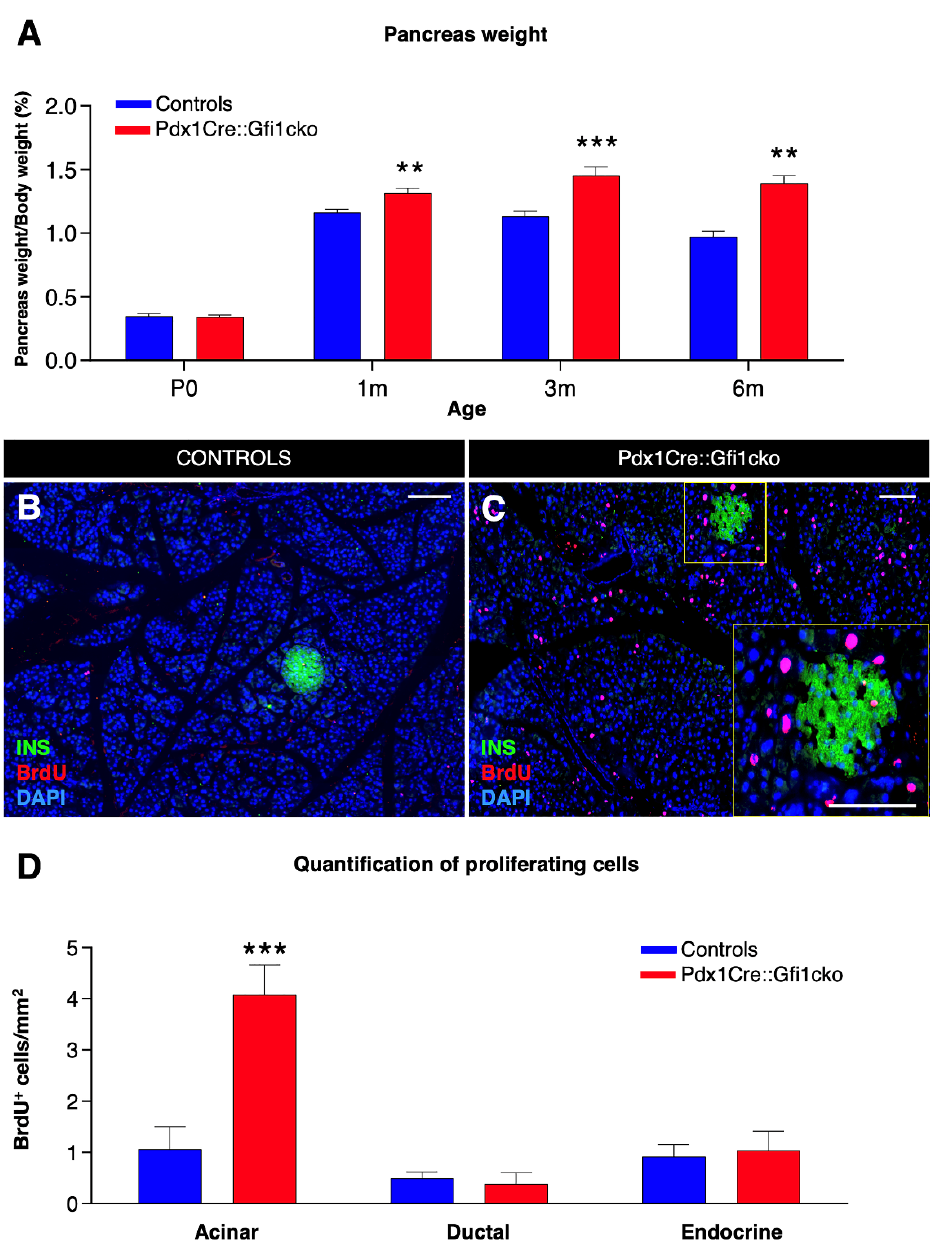
Figure 2. Loss of Gfi1 is associated with a dramatic increase in proliferation rate within the acinar compartment. Measurement of pancreas weight normalized to animal body weight at birth and 3 adult ages. ( n = 8 animals per genotype per (st) age) (** p < 0.01, *** p < 0.001) ( A ). Adult Pdx1Cre::Gfi1cko and controls were provided with BrdU for 5 days. Subsequently, pancreatic sections were analyzed by immunofluorescence. Objective magnification: 20×. Scale bar: 100 μ m ( B , C ). Quantitative analyses of BrdU-labelled cells in different pancreatic compartments ( n = 4 animals per genotype) (*** p < 0.001) ( D ).